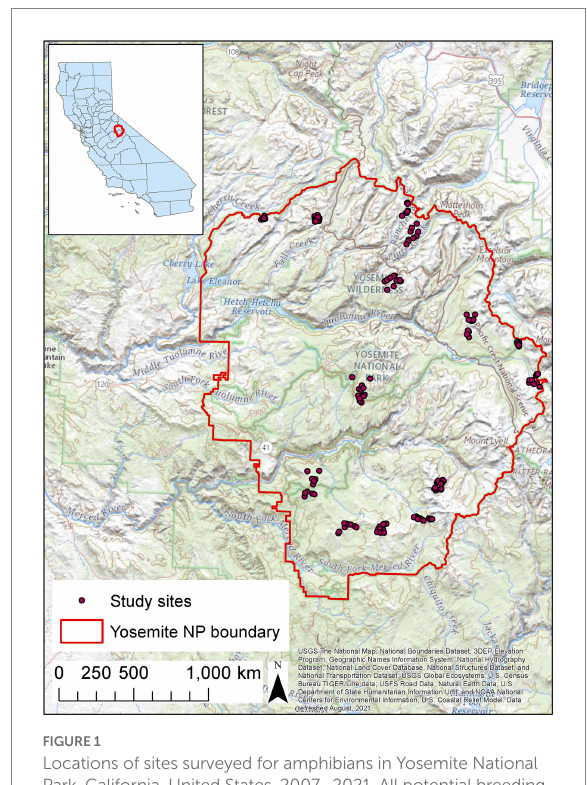
FIGURE 1 Locations of sites surveyed for amphibians in Yosemite National Park, California, United States, 2007–2021. All potential breeding sites in each of 14 watershed units were